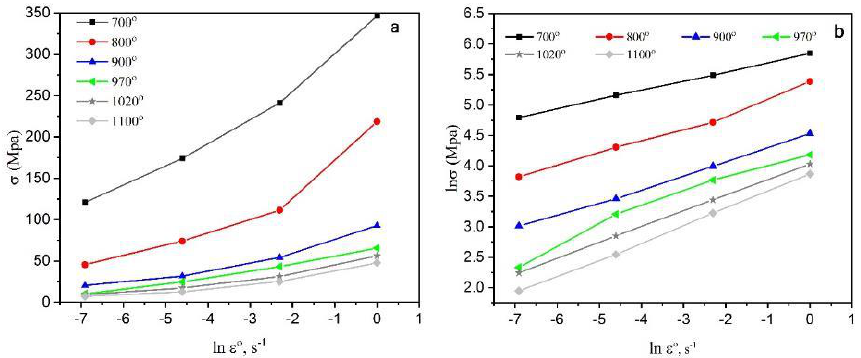
Fig. 4. True Stress-True Strain Curve of ATI425 titanium alloy at different strain rates and temperatures: (a) 970℃ (b) 1020℃ (c) 1100℃.